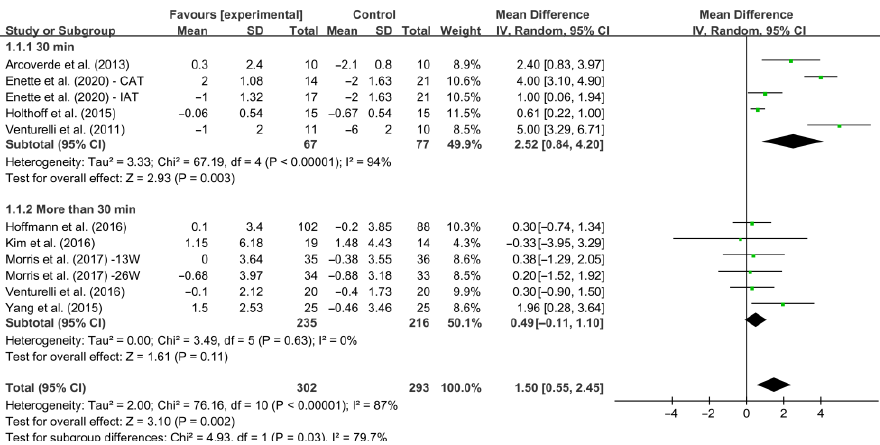
Figure 5. Meta-analysis results of the effect of the duration of intervention per session on cognitive function in AD patients [20,27,39 – 45]. function in AD patients